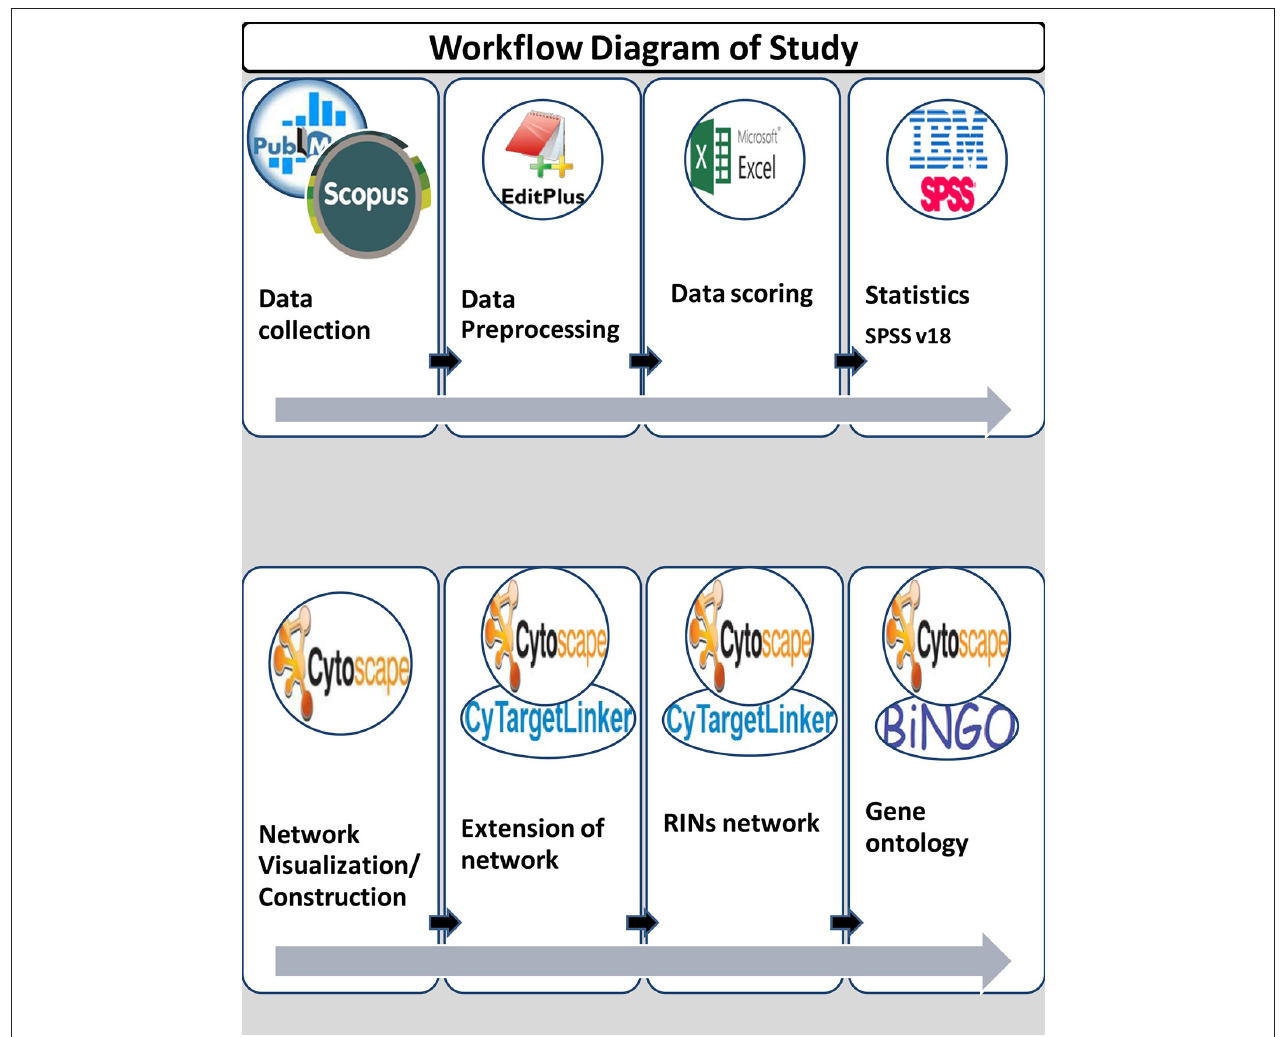
FIGURE 1 | Workflow diagram of study.